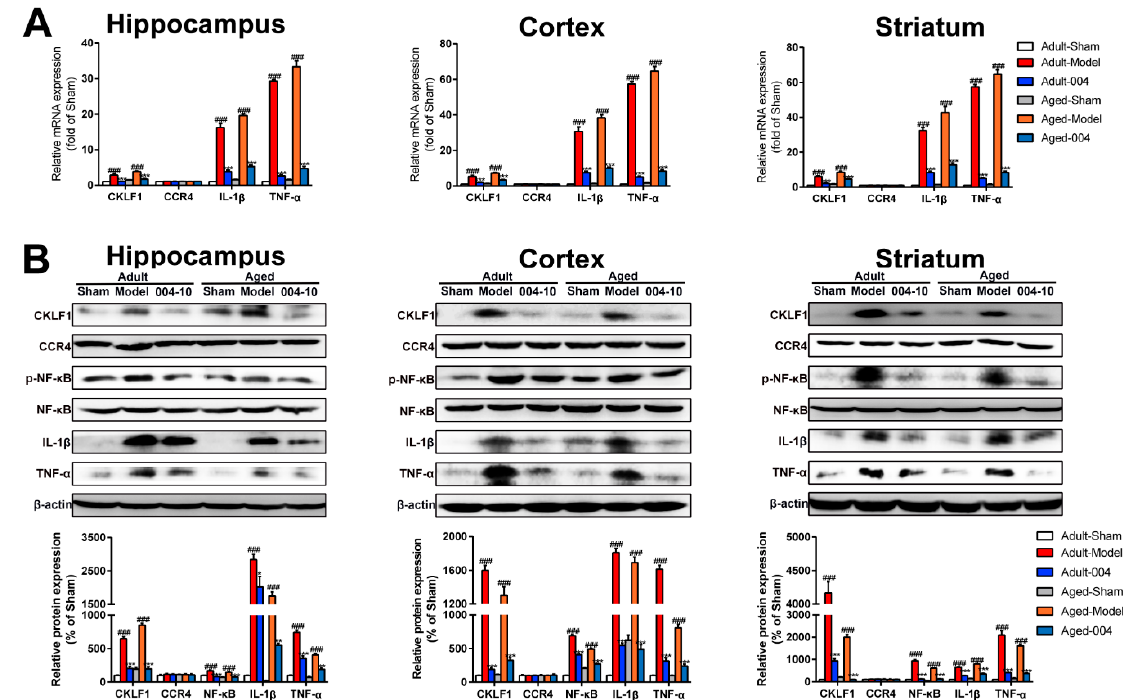
Figure 8. IMM-H004 decreases Permanent focal cerebral ischemia-induced brain inflammation in aged rats. ( A ) RT-PCR analysis for mRNA levels of CKLF1, CCR4, IL-1 β , and TNF- α in hippocampus, cortex, and striatum of aged rats. ( B ) Representative blots and densitometry data for CKLF1, CCR4, IL-1 β , and TNF- α hippocampus, cortex, and striatum of aged rats. Data are shown as the mean ± SD after normalization to the sham ( n = 6/group). ### p < 0.001 vs. sham; ** p < 0.01 vs. model; *** p < 0.001 vs. model.